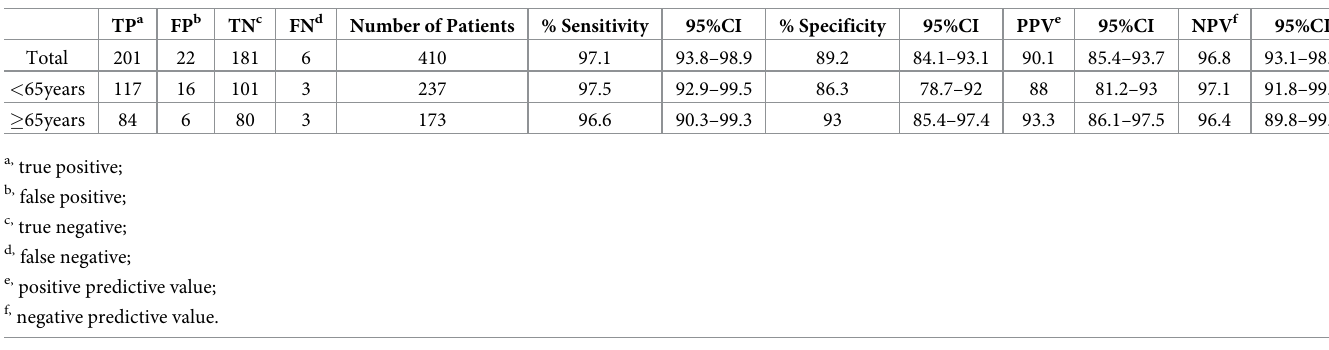
Table 2 showed the accumulated sensitivity and specificity of ImunoAce Flu from within 12 hours after the onset of illness to > 48 hours after the onset of illness. Within 48 hours after the Table 1. Sensitivity and specificity of ImunoAce Flu according to age